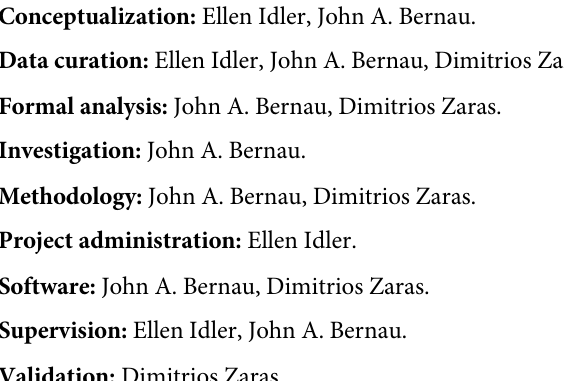
S1 Table. Public health guidance for religious groups from the centers for disease control and prevention and the world health organization. S2 Table. Faith-based and religious organization statements and guidance on COVID-19. S3 Table. Top 30 topic contents with author characterization of themes. S1 Fig. Frequency of New York Times articles by week and